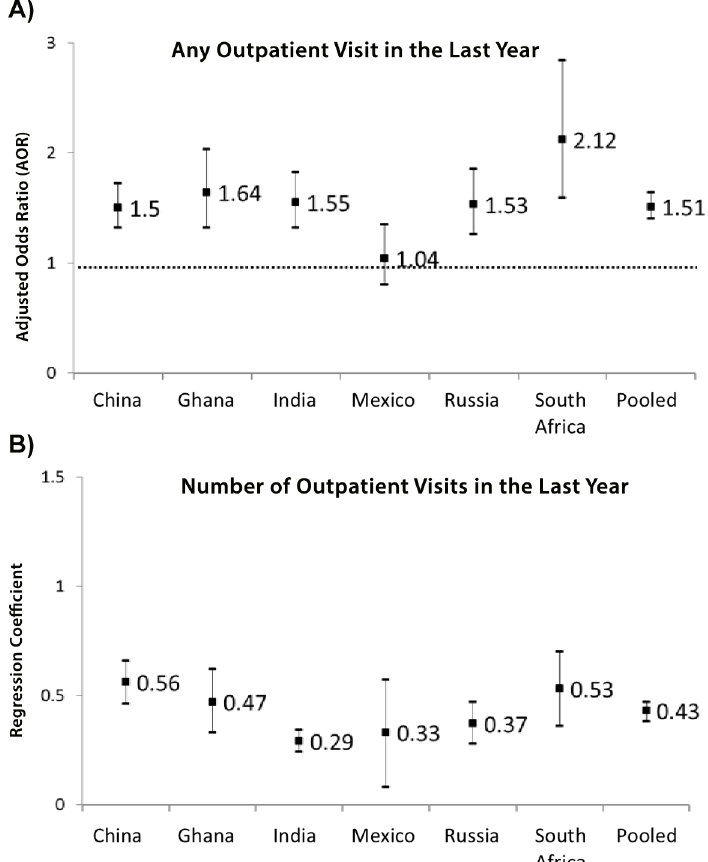
Fig 2. Association between number of NCDs and healthcare utilisation- any outpatient utilisation (Fig 2a); Association between number of NCDs and healthcare utilisation- number of outpatient visits (Fig 2b). Figures in the last column are coefficients and 95% CI for the variable “ number of NCD ” from regression models adjusting for all covariates. Logistic model is used to estimate any visit for outpatient/inpatient service, and negative binomial model is used for number of visit/ hospitalisation days